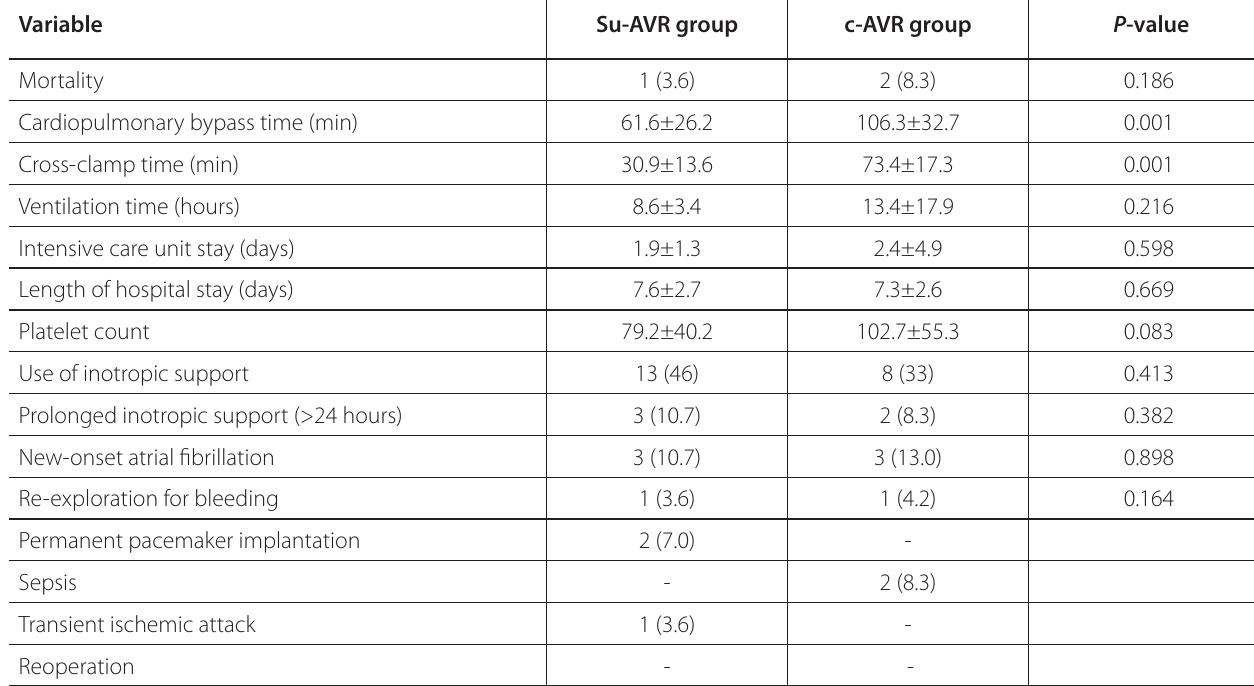
Table 3 . Operative and postoperative